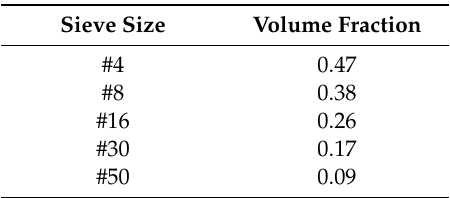
Table 8. Volume fractions for each sand fraction used to estimate the rheological properties of each mortar